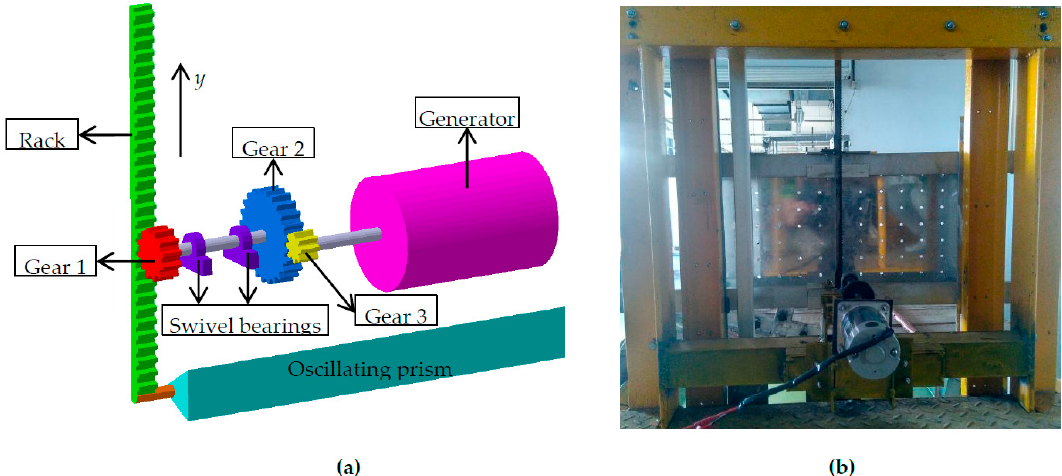
Figure 3. Power take-off system ( a ) Diagram of Power take-off system; ( b ) Mounting position.